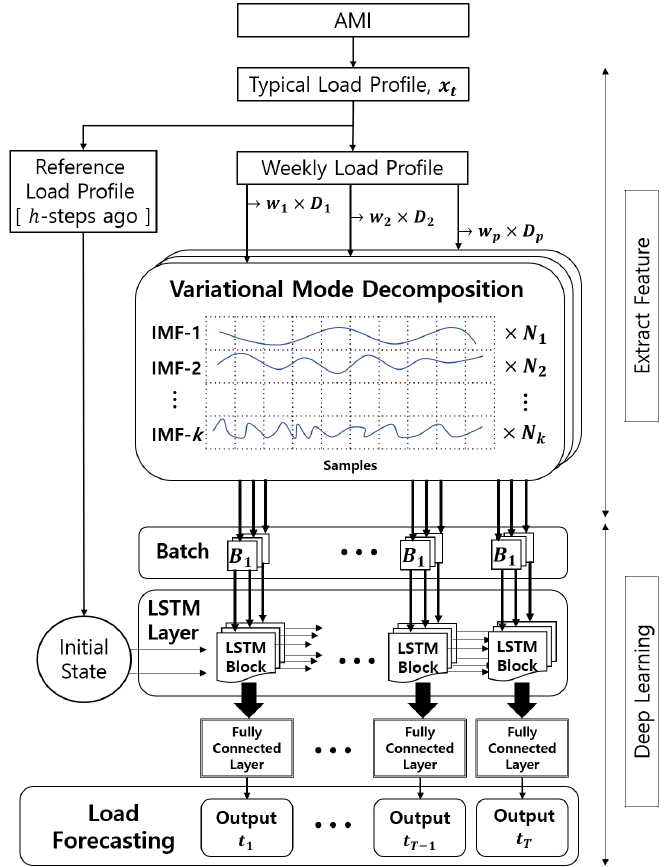
Figure 3. Deep-learning load forecasting based on the multi-decomposition